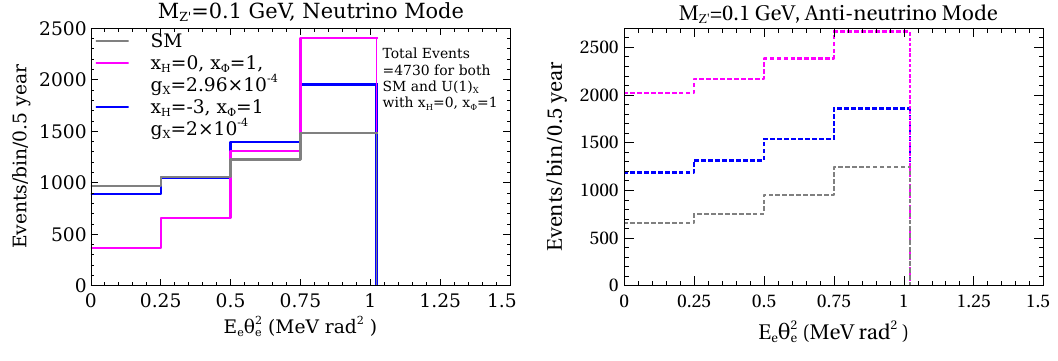
Figure 4 . Neutrino (anti-neutrino) events for the SM and U(1) X